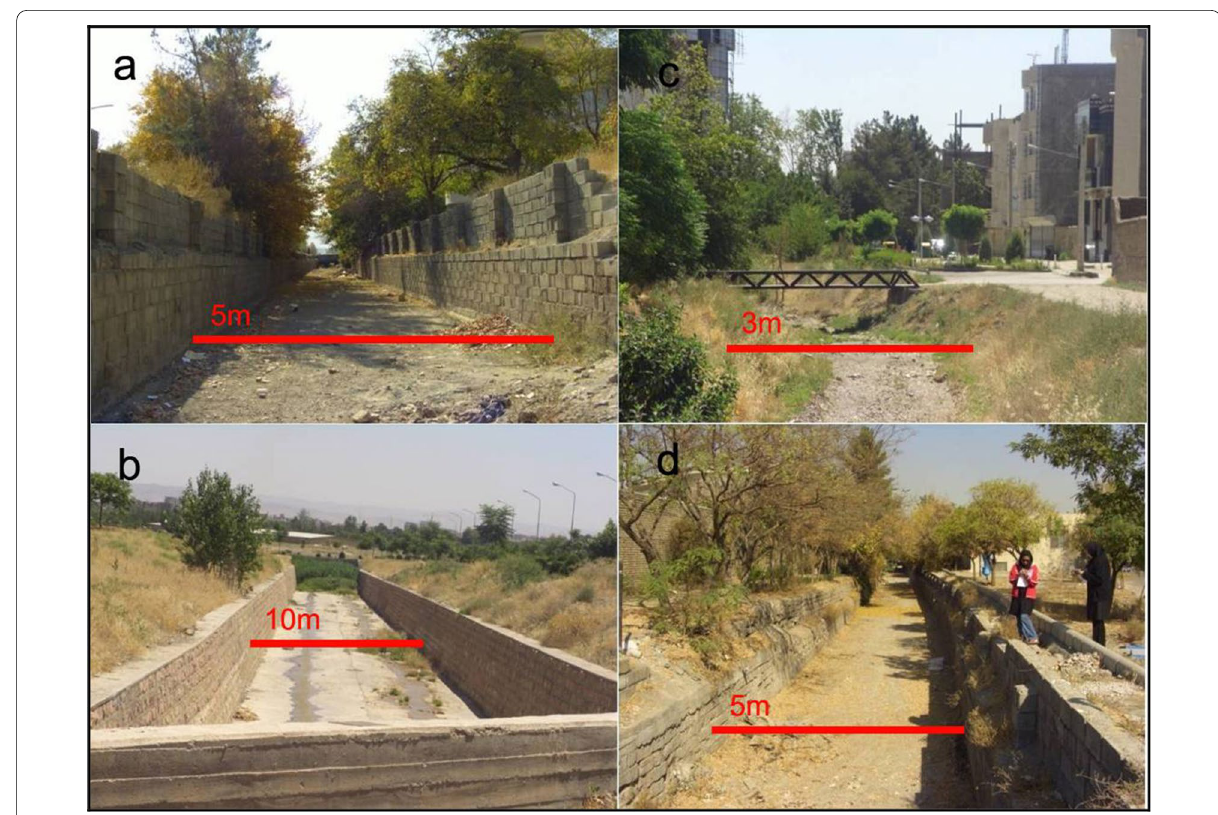
Fig. 9 The existing structure of outlet cross-sections in the field observation for some watersheds including a W9, b W10, c W20, and d